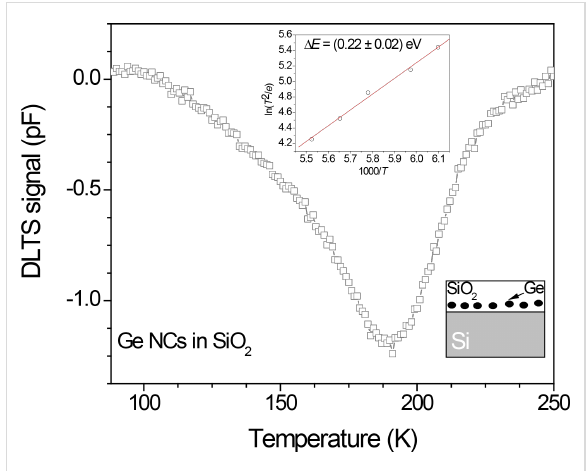
Figure 2: DLTS spectrum of a MOS structure with Ge NCs embedded in the oxide, with Arrhenius plot in the inset. By careful adjustments of the measurement settings, the thermal emission of electrons from the NCs is detected by DLTS (for more explanations on DLTS analysis see